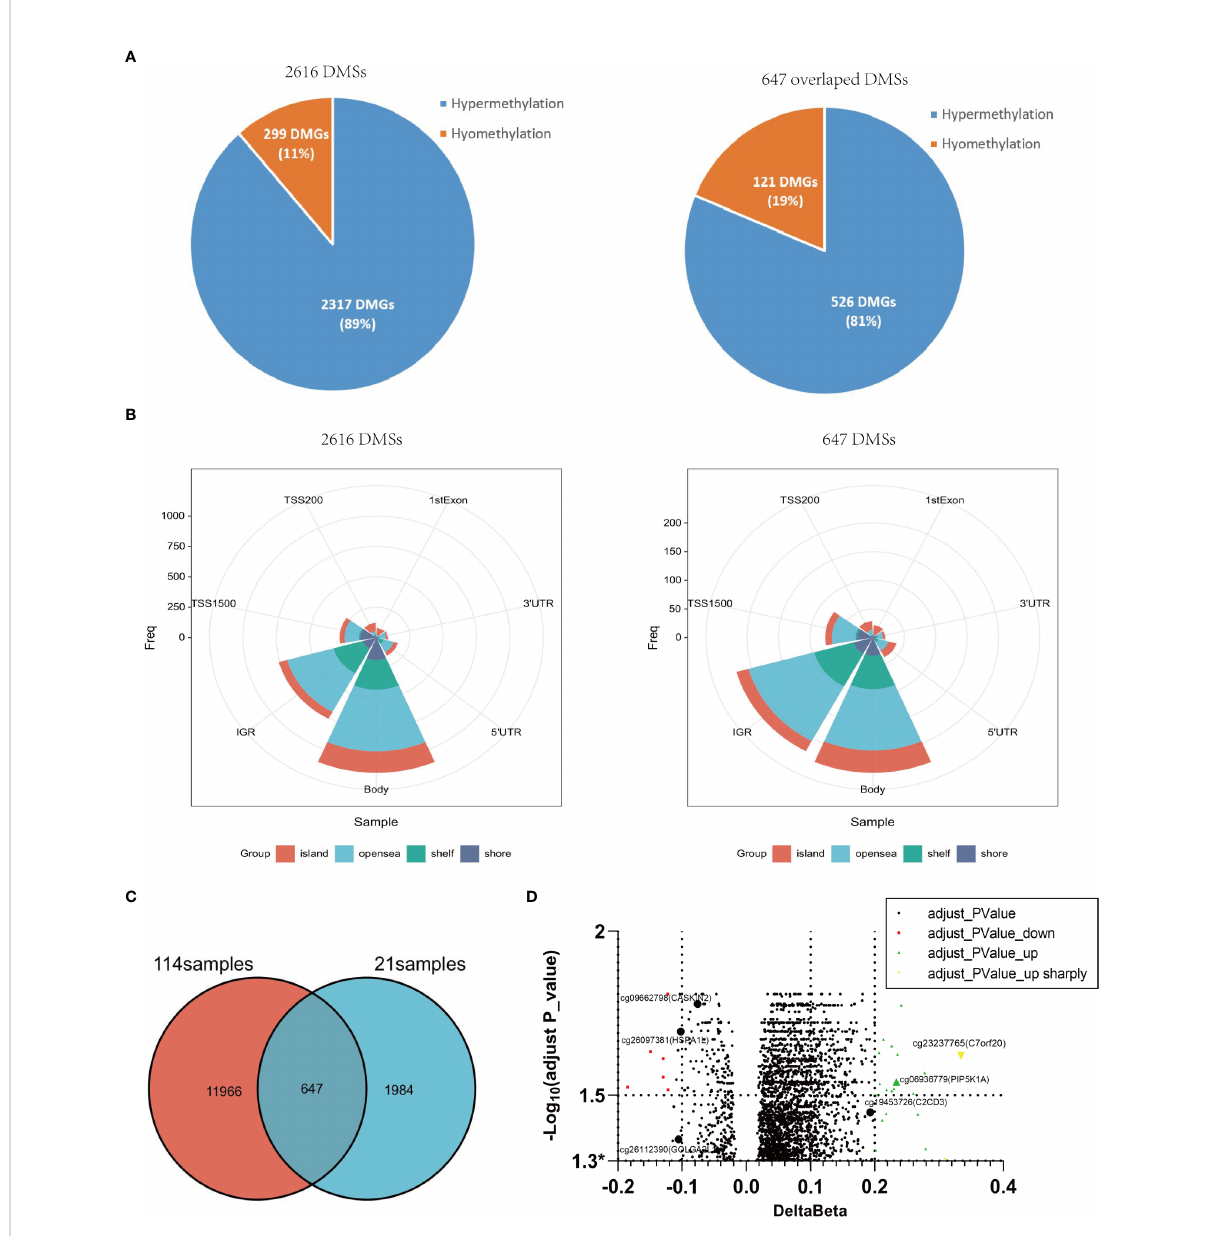
FIGURE 2 Differential methylation characteristics of 21 samples with and without Munro ’ s microabscess and overlapping with 114samples. (A) : The number, proportion, and distribution of 2,616 DMSs with or without Munro ’ s microabscess in 21 samples. (B) The overlapped DMSs between 114 samples and 21 samples. (C) The number, proportion, and distribution of 647 overlapped DMSs with or without Munro ’ s microabscess. (D) Volcano plot using -Log 10 (adjust P_value) and delta Beta at 2616 DMSs.* represents adjusted